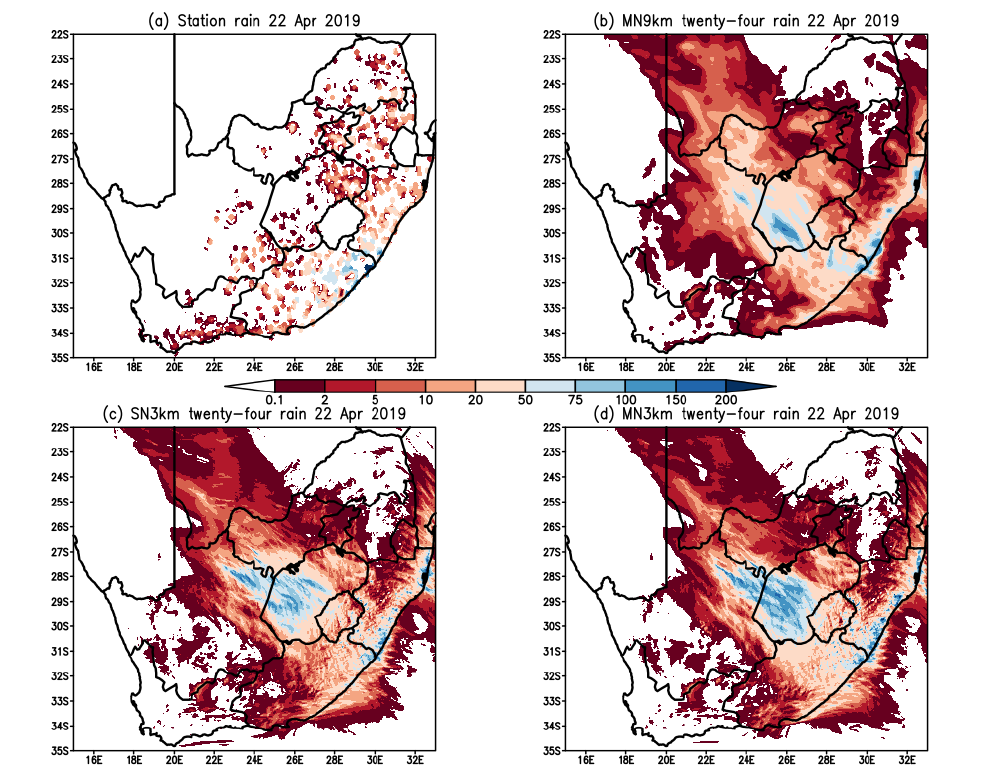
Figure 7. Observed twenty-four rainfall (mm) on ( a ) 22 April 2019 and CCAM simulated rainfall for ( b ) SN3km ( c ) MN3km and ( d ) MN9km, for the same